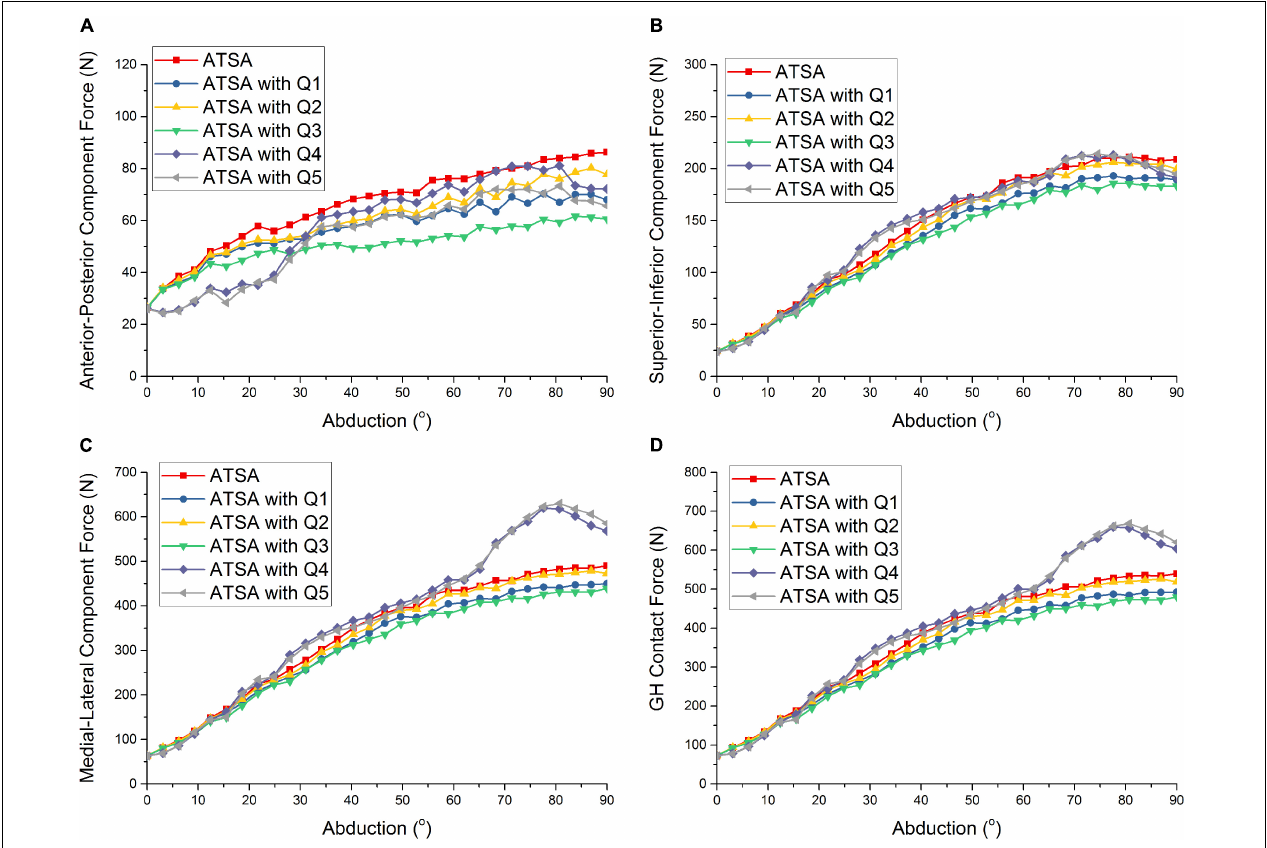
FIGURE 4 | Predicted anterior-posterior component force (A) , superior-inferior component force (B) , medial-lateral component force (C) , and GH contact force (D) of ATSA under intact rotator cuff and different rotator cuff deficiencies. Q1: infraspinatus deficiency; Q2: supraspinatus deficiency; Q3: supraspinatus and infraspinatus deficiencies; Q4: subscapularis deficiency; Q5: supraspinatus, infraspinatus, subscapularis, and teres minor